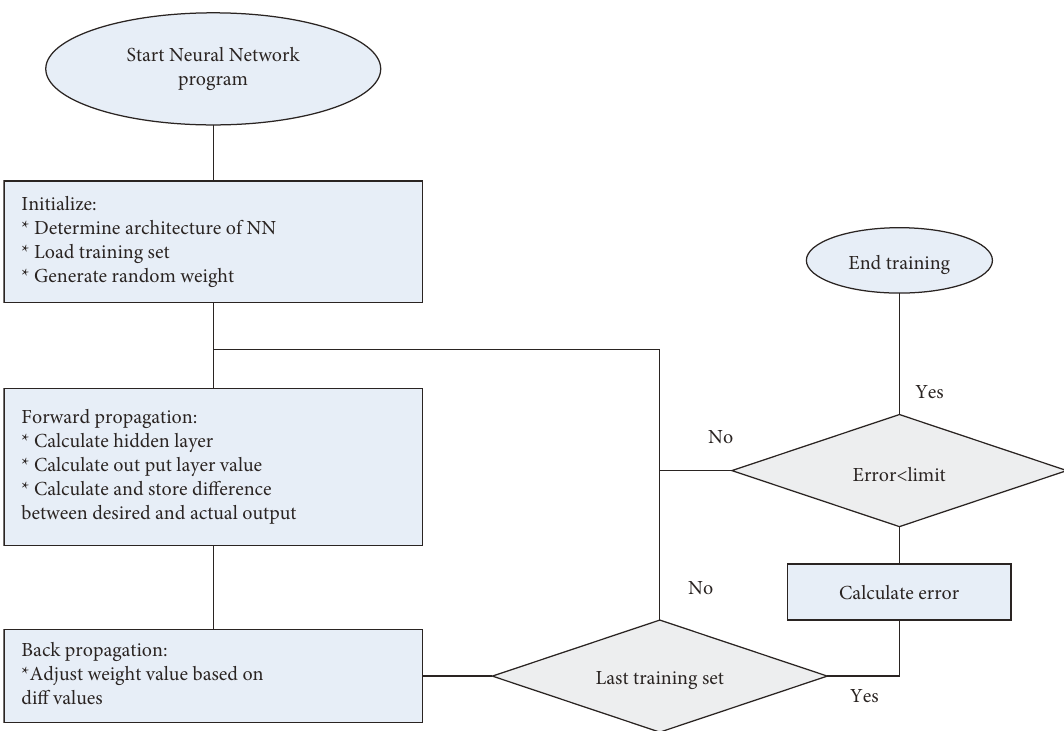
Figure 5: Flowchart of ANN back-propagation